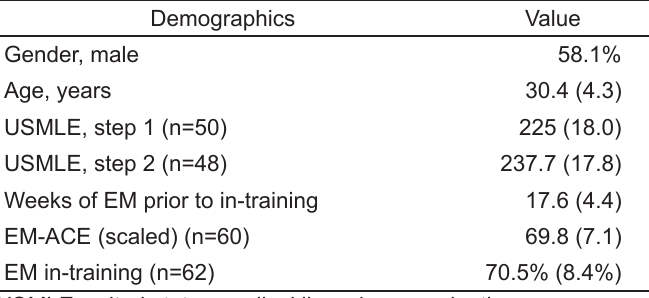
Table 1. Demographics of interns completing the emergency medicine advanced clinical examination (EM-ACE) and the in- training exam.